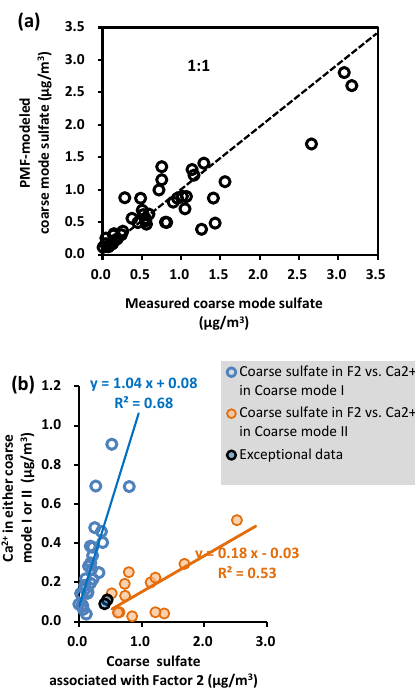
Figure 9. (a) Total sulfate in the coarse mode versus PMF-model estimated sulfate. (b) Relationship of coarse-mode sulfate apportioned to the NH 4 HSO 4 -containing coarse particles (i.e., Factor 2) with Ca 2+ concentration in either Coarse-mode I (blue open circles) or Coarse mode II (yellow filled circles). There are two exceptional data (filled circles with blank outline) that do not fit in either of the two groups.